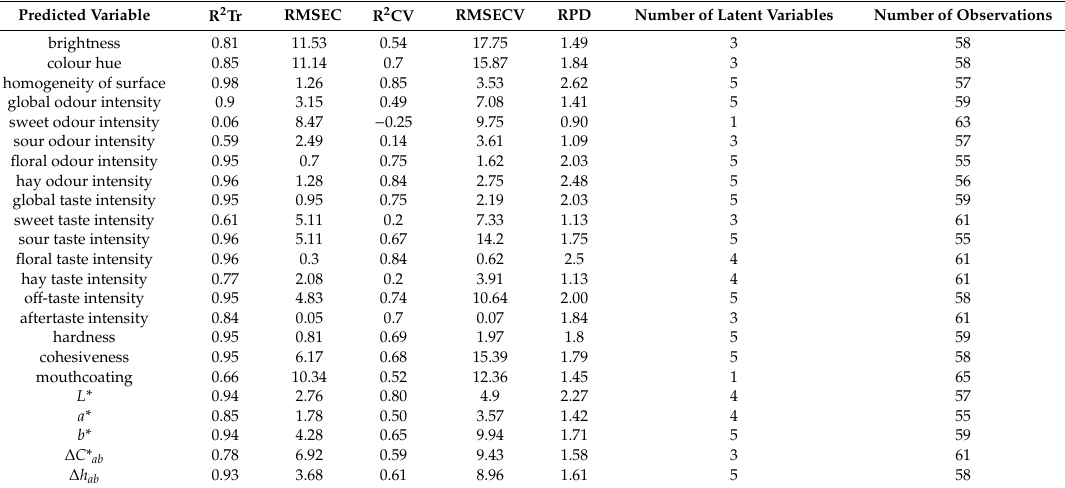
= 65); ( b ) PCA loadings Figure 2 Figure 2. Results of the near-infrared spectroscopy: ( a ) PCA score plot NIRS ( n of the NIRS; ( c ) LDA score plots built for the classification of botanical groups with 95% confidence interval ellipses. x denotes the center of the ellipses, on figure ( c ) solid point are for the training set, and hollow points are for the validation set. Table 6. Results of the regression models built on the properties of sensory profile analyses and colour parameters of pollen samples based on data of the NIR spectroscopy at the wavelength range of 950–1650 after Savitzky-Golay smoothing and MSC